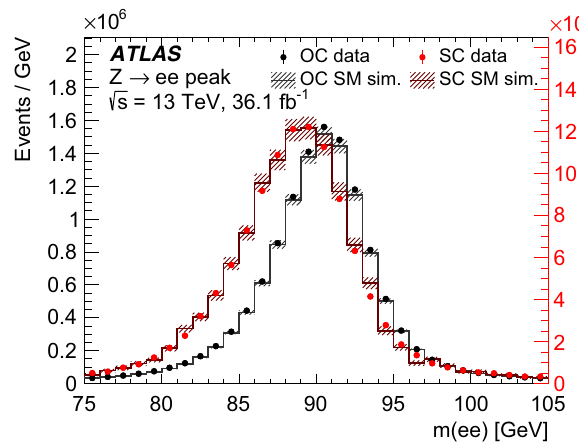
Fig. 2 Dielectron mass distributions for opposite-charge (black) and same-charge(red)pairsfordata(filledcircles)andMCsimulation(con- tinuous line). The latter includes a correction for charge misidentifica- tion. The hatched band indicates the statistical error and the luminosity uncertainty summed in quadrature applied to MC simulated events